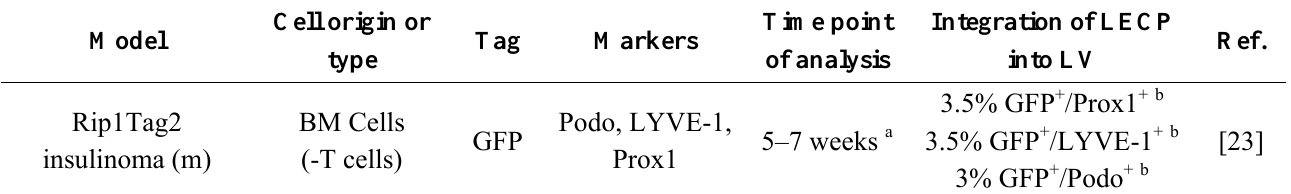
Table 5. LECP incorporation into tumor-induced lymphatic